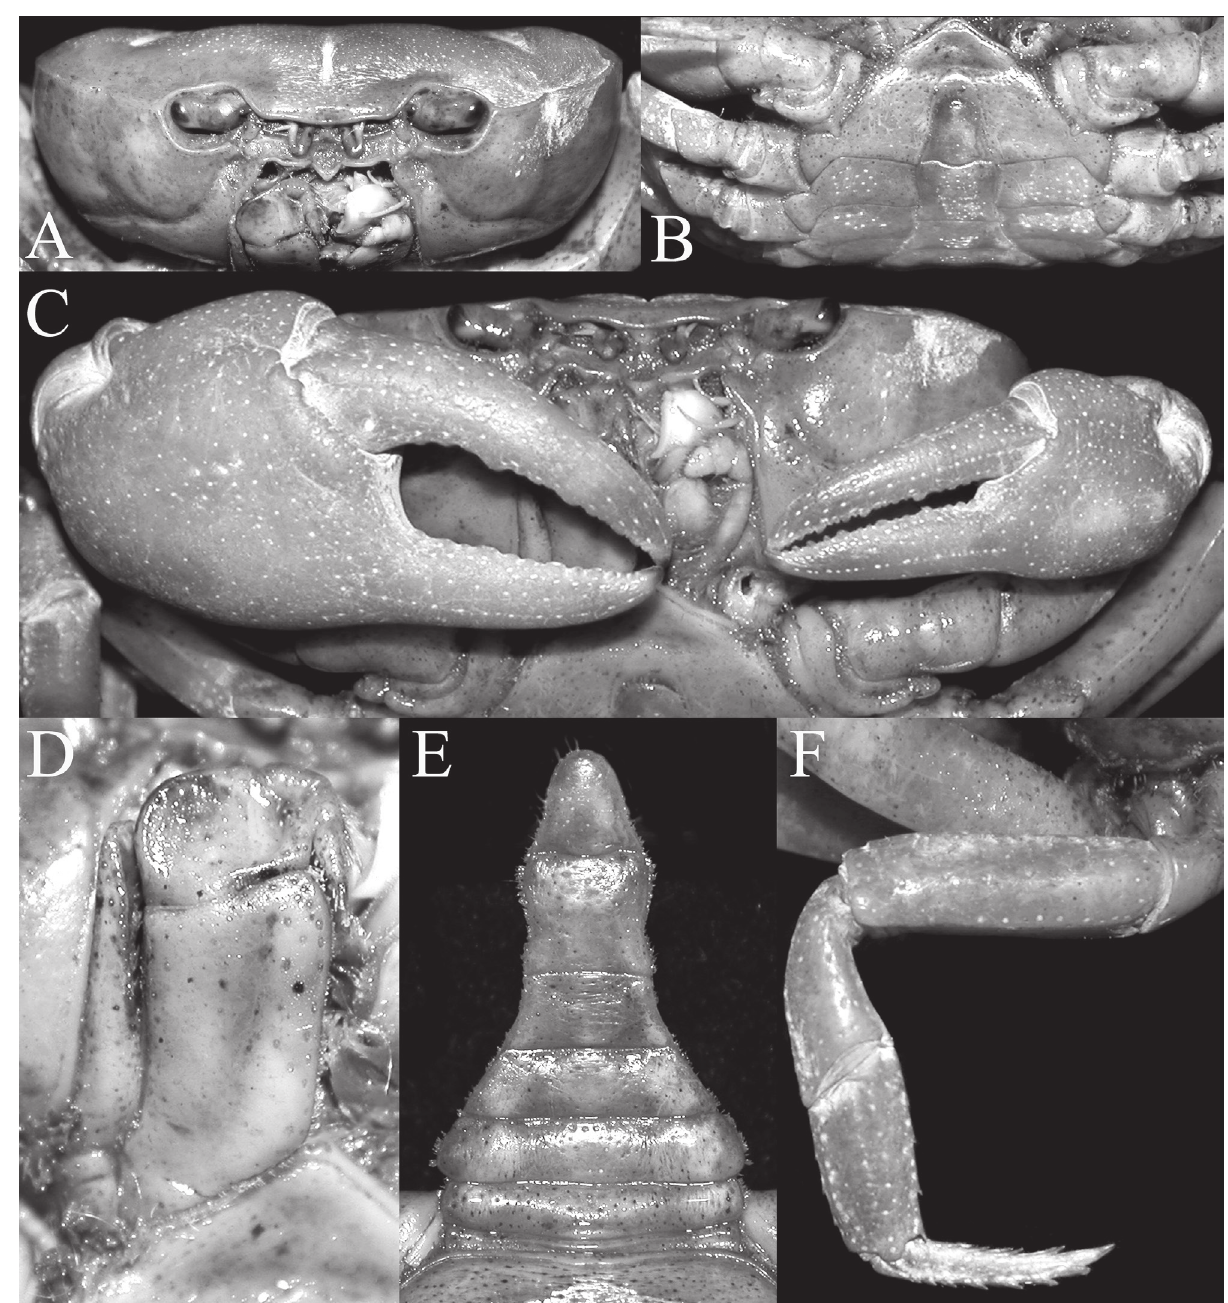
Figure 3. Sundathelphusa tuerkayi , new species, holotype, male (34.7 × 26.5 mm) (SMF 1799a), Lombok, Indonesia. A, frontal view; B, anterior thoracic sternum and abdomen; C, chelipeds; D, right third maxilliped; E, abdomen; F, right fourth ambulatory